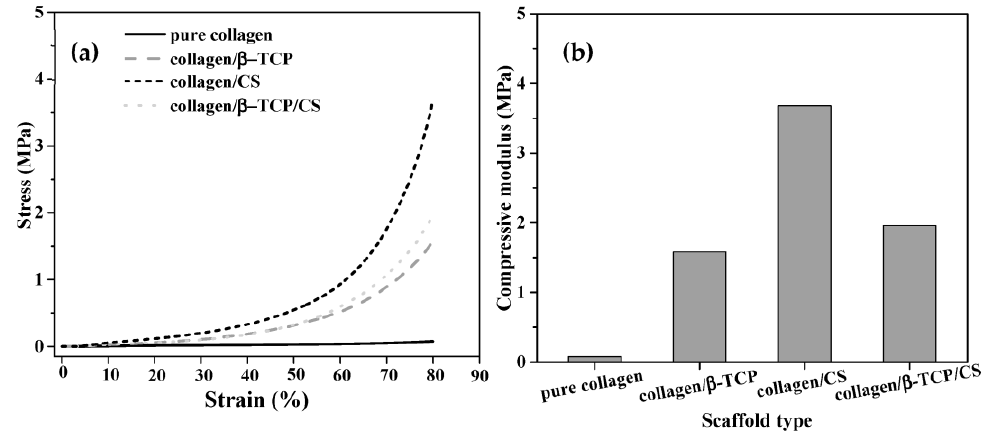
Figure 5. ( a ) Compressive stress–strain curve and ( b ) compressive modulus of pure collagen scaffold and collagen/β - TCP, collagen/CS, and collagen/β -TCP/CS composite scaffolds.